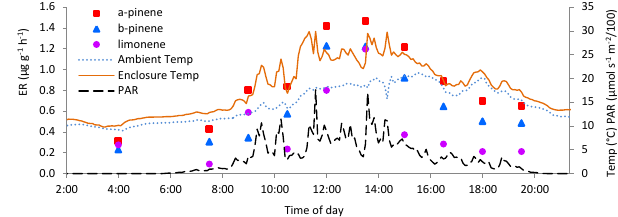
Fig. 8. Emission rates for α -pinene, β -pinene, and limonene from a honey locust branch enclosure on 9 June with concurrently mea- sured environmental